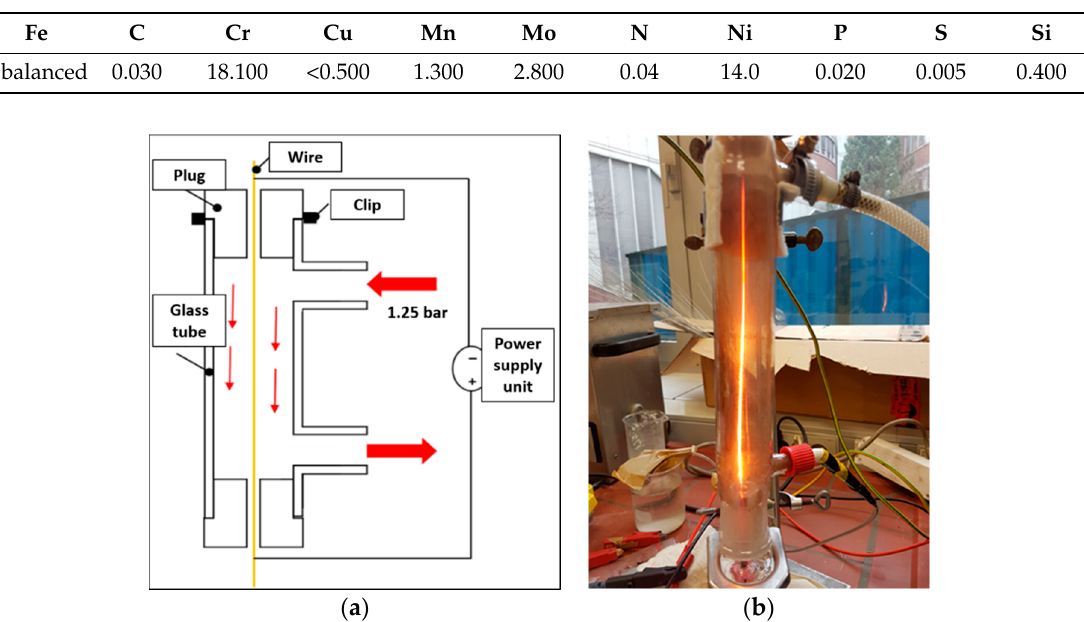
Figure 1. ( a ) Conductive heat treatment set-up scheme and ( b ) during heat treatment.